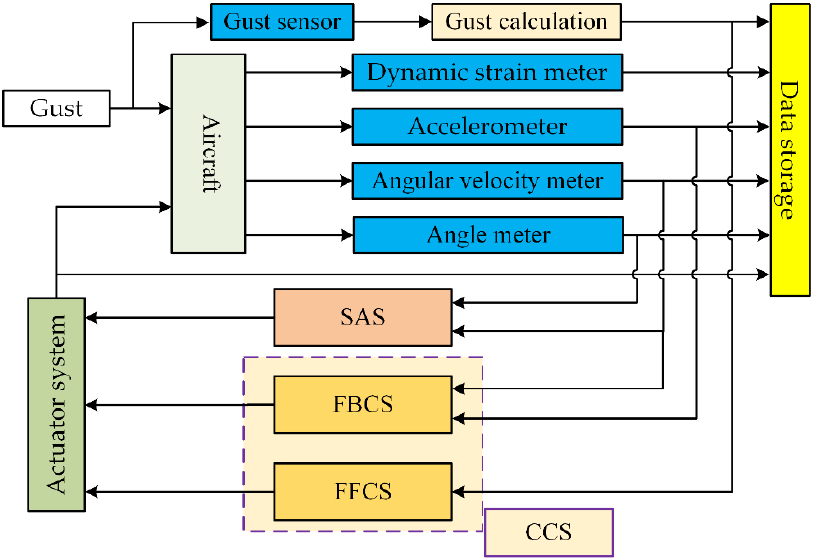
Figure 21. Measurement and control system structure.